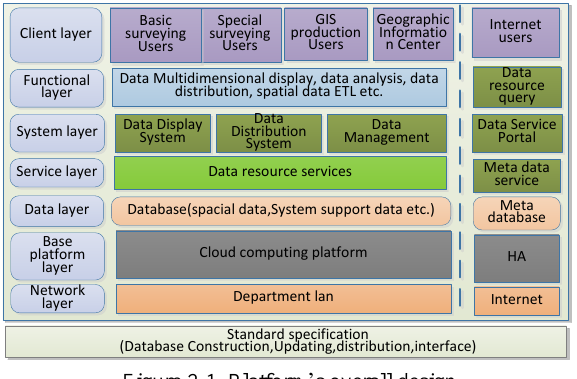
Figure 2-1. Platform’s overall